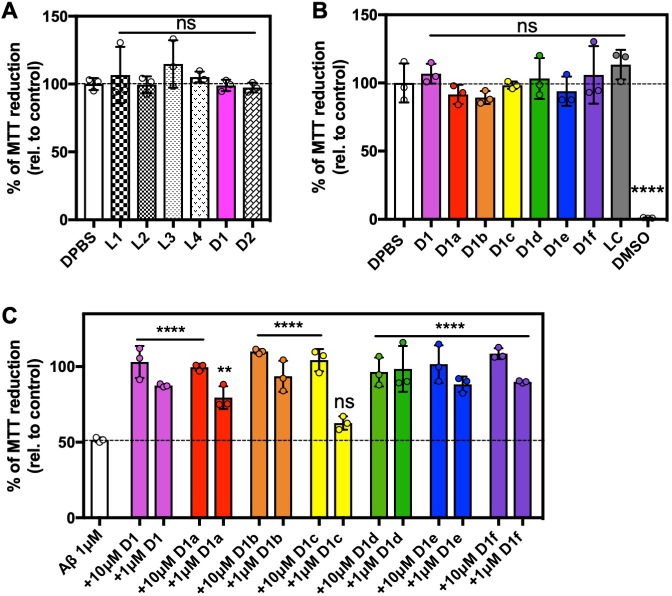
Extended Toxicity data.(A, B) Peptide inhibitors are not toxic. 100 μM of each peptide inhibitor was incubated for 12 hr at 37°C and then diluted 1:10 with pre-plated N2a cells. Cytotoxicity was quantified using MTT dye reduction. Bars represent mean with individual technical replicates, error bars display one standard deviation. (C) Second generation peptide inhibitors reduce the cytotoxicity of Aβ1–42. 10 μM Aβ1–42 was incubated alone or with 10 μM and 100 μM of each peptide inhibitor for 12 hr at 37°C and then diluted 1:10 with pre-plated N2a cells. Cytotoxicity was quantified using MTT dye reduction. Bars represent mean with individual technical replicates, error bars display one standard deviation (n = 3; ns = not significant; ****, p<0.0001 using an ordinary one-way ANOVA- Dunnett’s relative to leftmost column).